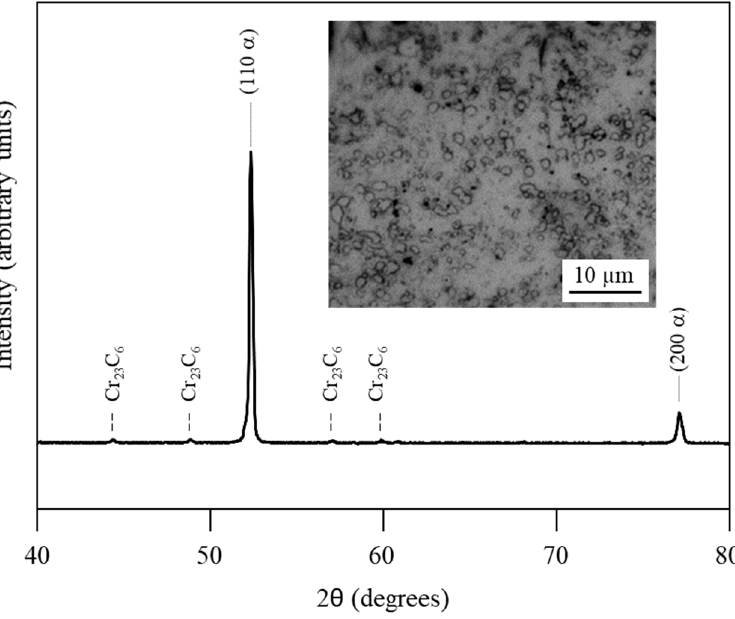
Figure 2. XRD pattern and optical micrograph of the raw 420 stainless steel plate.